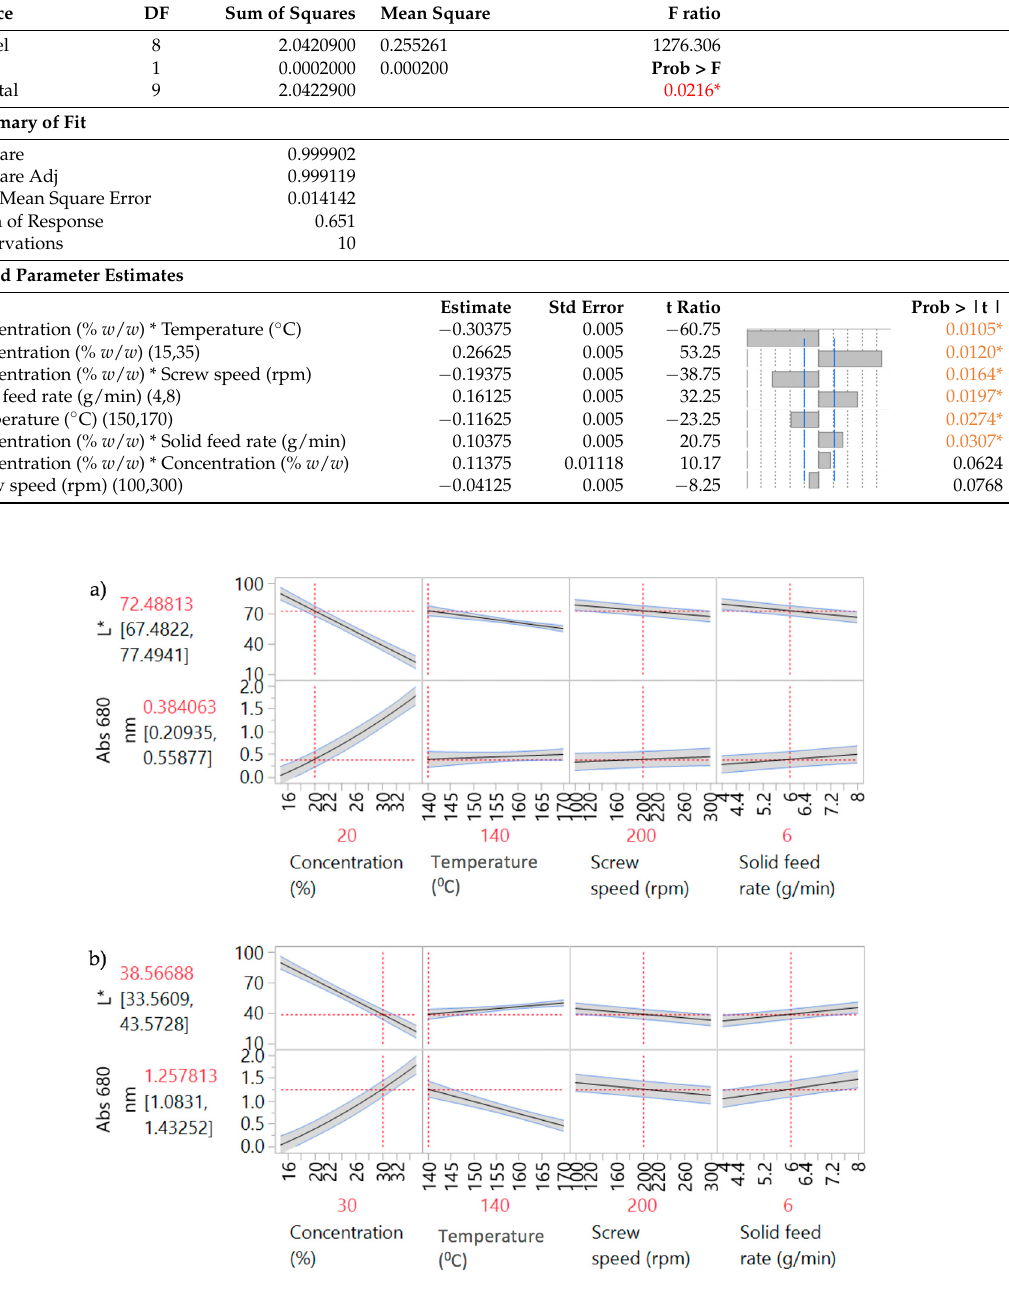
Figure 4. Prediction profilers for DoE1 for ( a ) 20% w / w and ( b ) 30% w / w PRX concentrations.